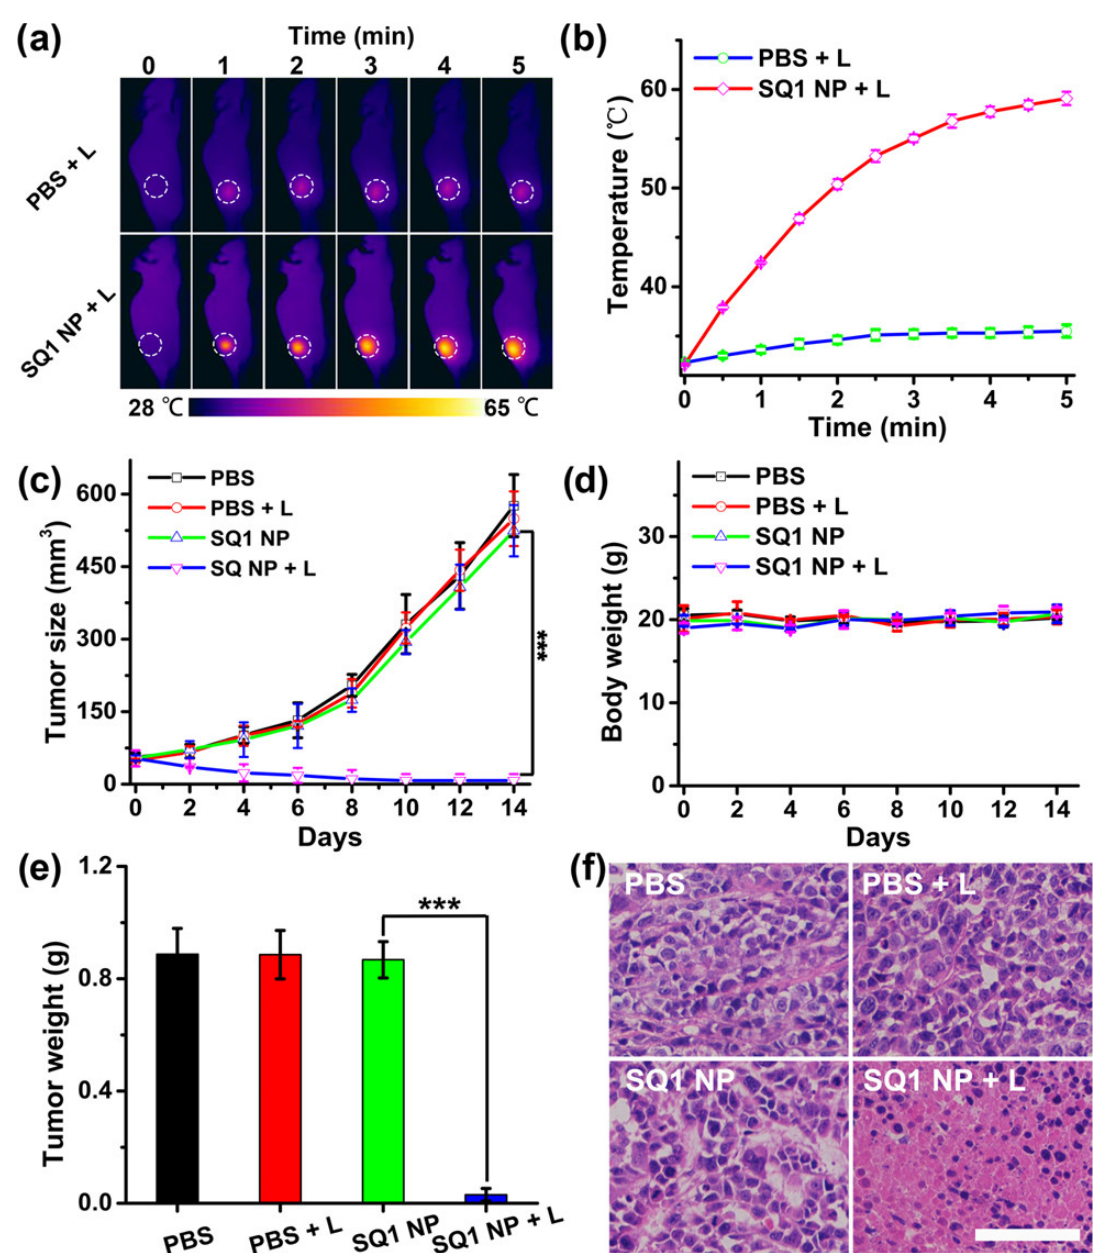
Figure 3. PTT effects of Squarine dye based copolymer NPs on breast tumor burden on s mice. ( a ) Thermal imaging; ( b ) Thermal variations in tumor during PTT; ( c ) Tumor growth inhibition and ( d ) body weight analysis during treatment period; ( e ) Weight measures of tumor lesions post treatment with PBS, PBS + L, SQ1 NP, SQ1 NP + L. L refers NIR laser (915 nm, 0.5 W/cm 2 ). Data present as mean ± SD, n = 5 (*** p < 0.01). ( f ) Histochemical analysis of tumor sections treated with PBS, PBS + L, SQ1 NP, SQ1 NP + L. The scale bar is 50 μ m. (Reprinted permission American Chemical Society, 2020) [74] .